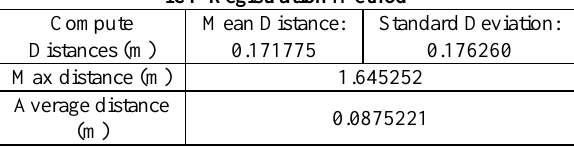
Table 8. Computed Values for nearest neighbor C2C distance